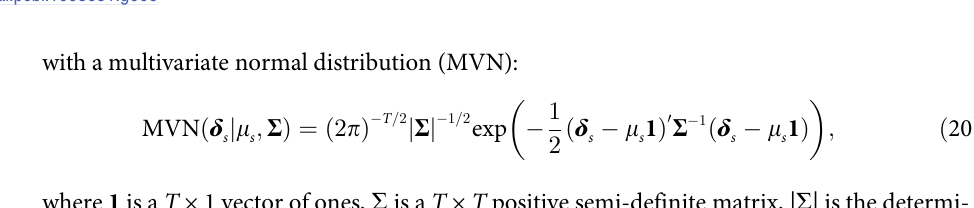
Þ (grey lines) for North Dakota, Nevada, and Illinois. ^ g s ; t